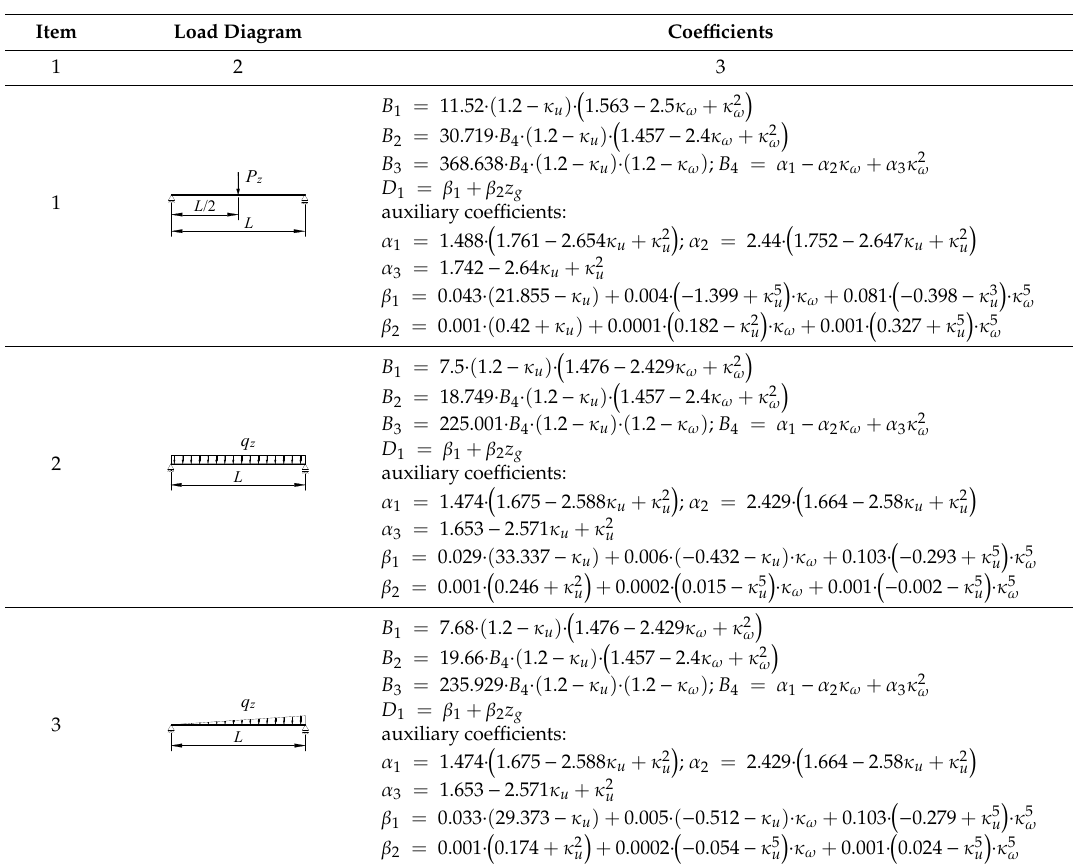
Table 2. Coefficients B 1 , B 2 , B 3 , B 4 and D 1 for selected diagrams of transverse load. Item Load Diagram